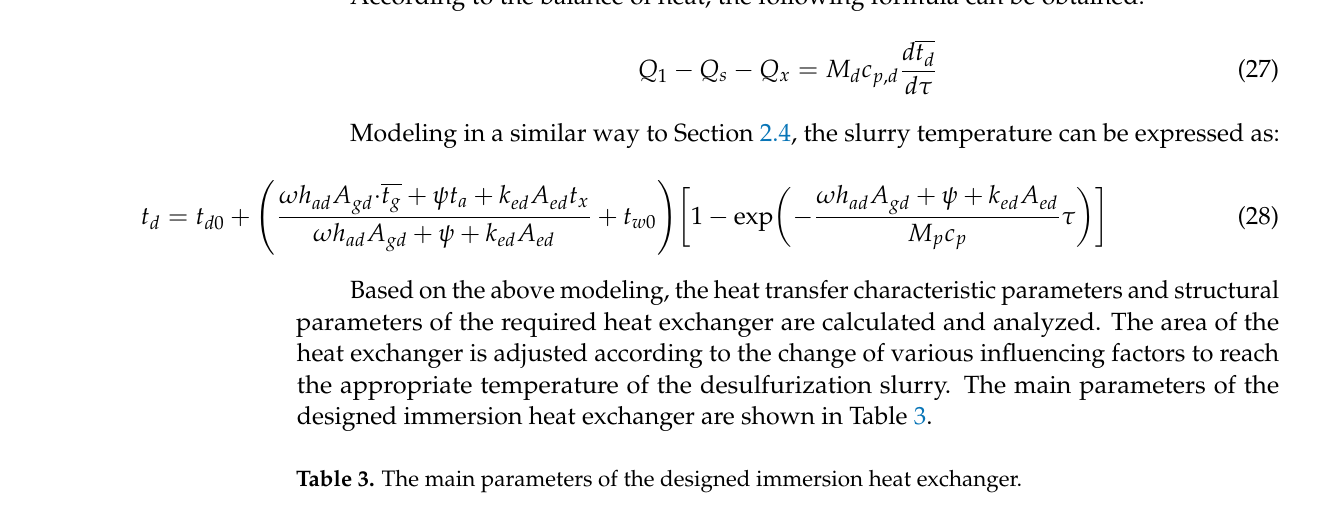
Table 3. The main parameters of the designed immersion heat exchanger. Item Flue Gas Secondary Water Inlet temperature ( ◦